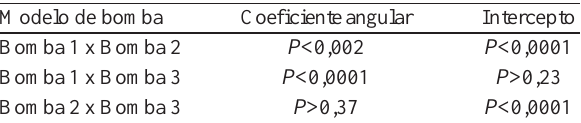
Tabela 3. Comparação entre regressões das medidas de pressão média de calibração dinâmica e respectivas diferenças de pressão para as três bombas